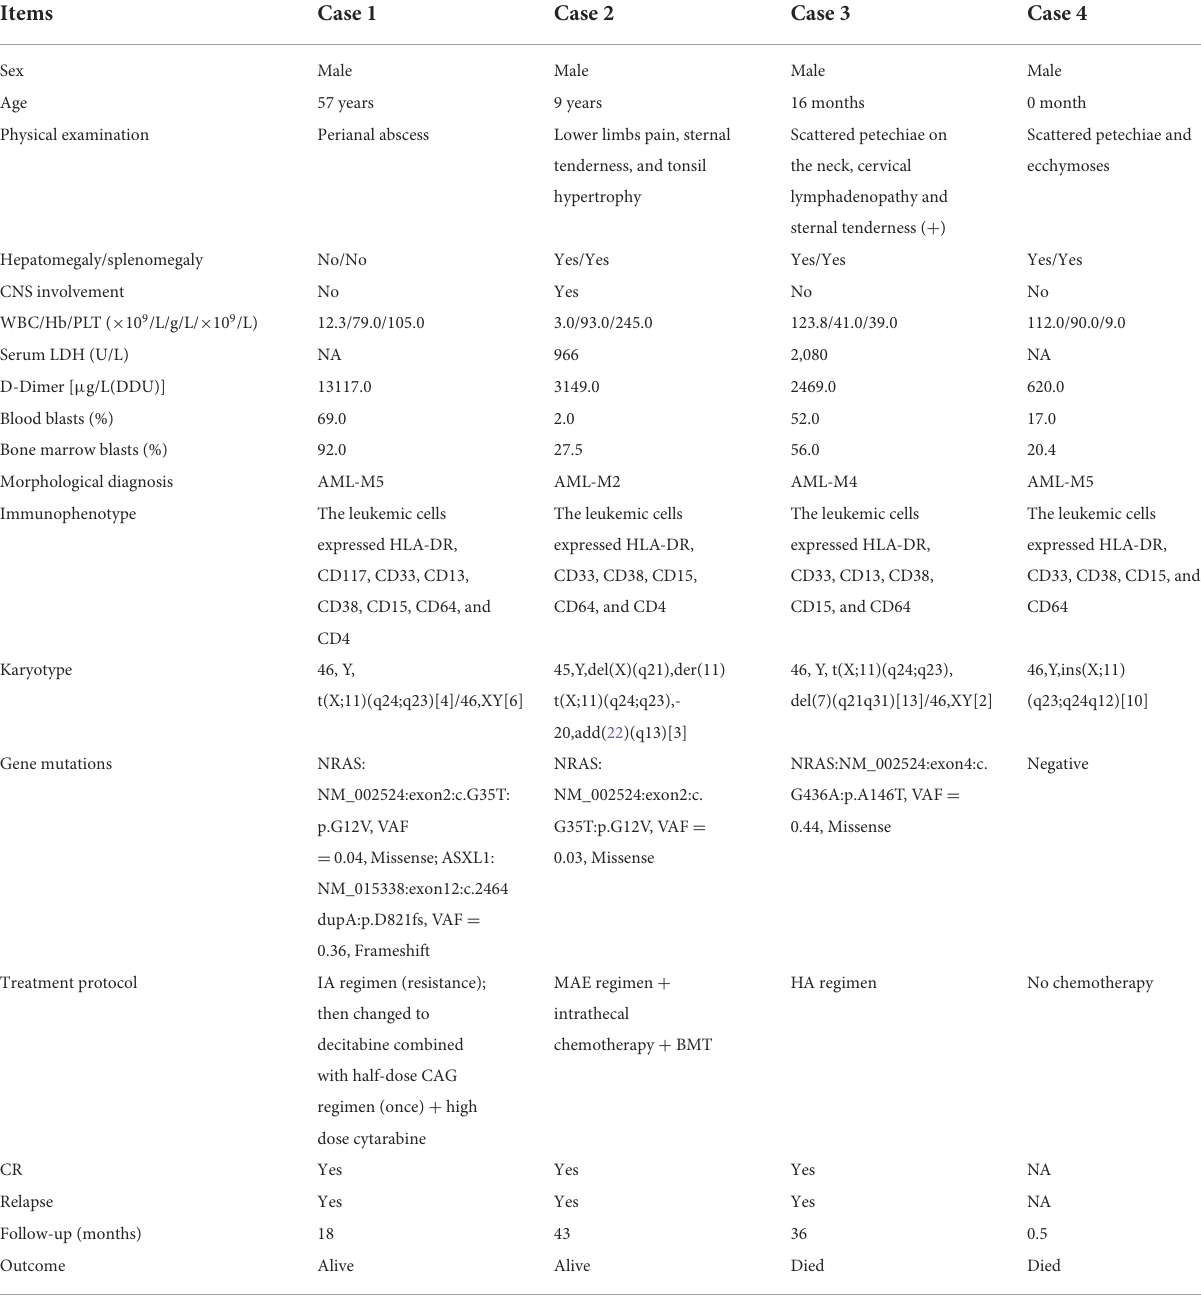
TABLE 1 Clinical features of four KMT2A-SEPT6 -positive AML